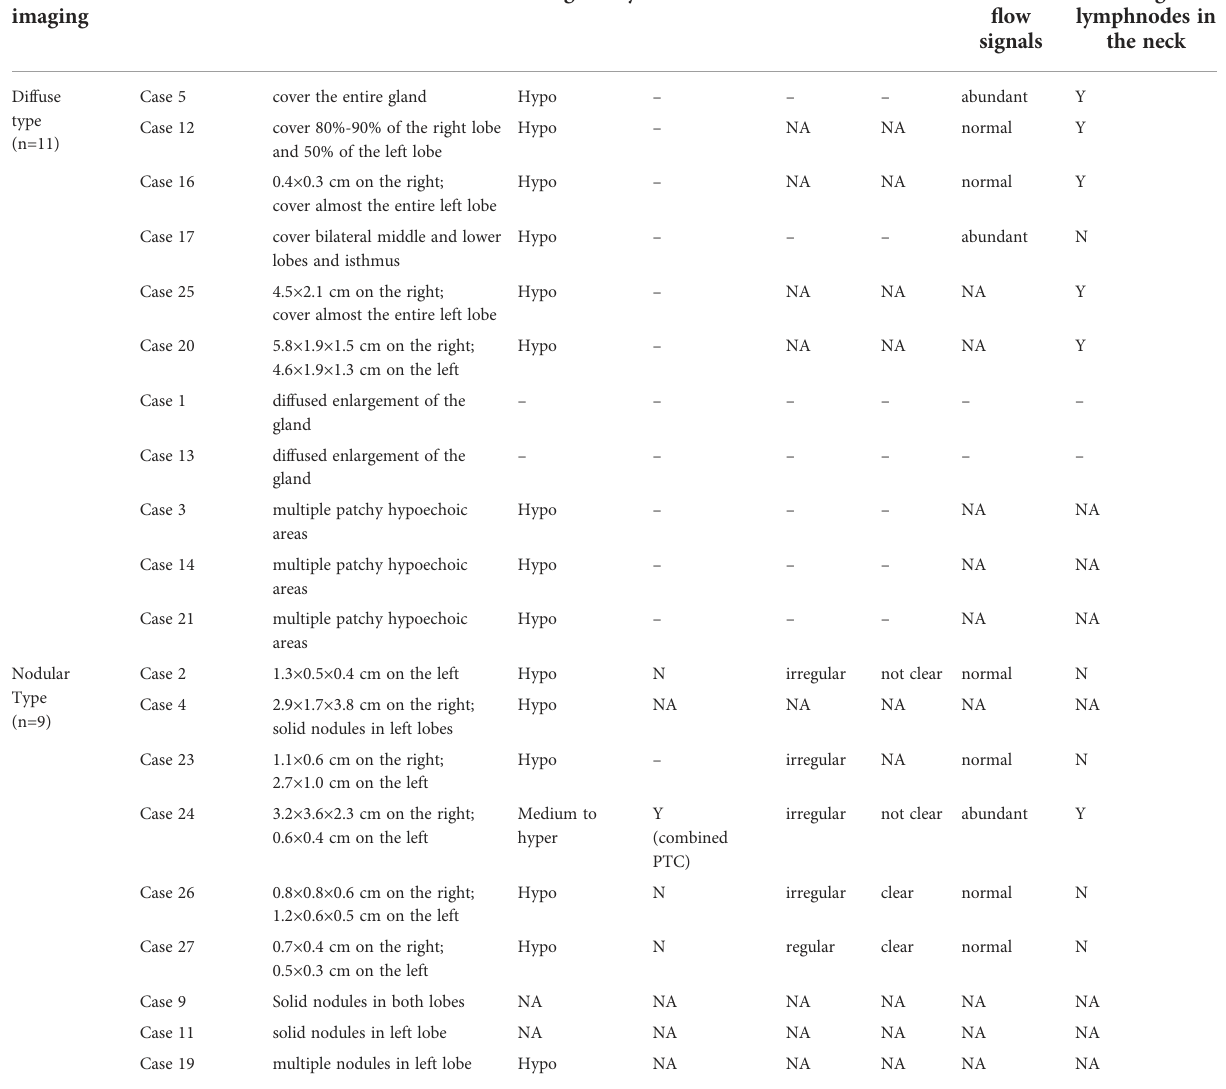
TABLE 3 Ultrasonographic features of thyroid involvement of LCH. Ultrasound